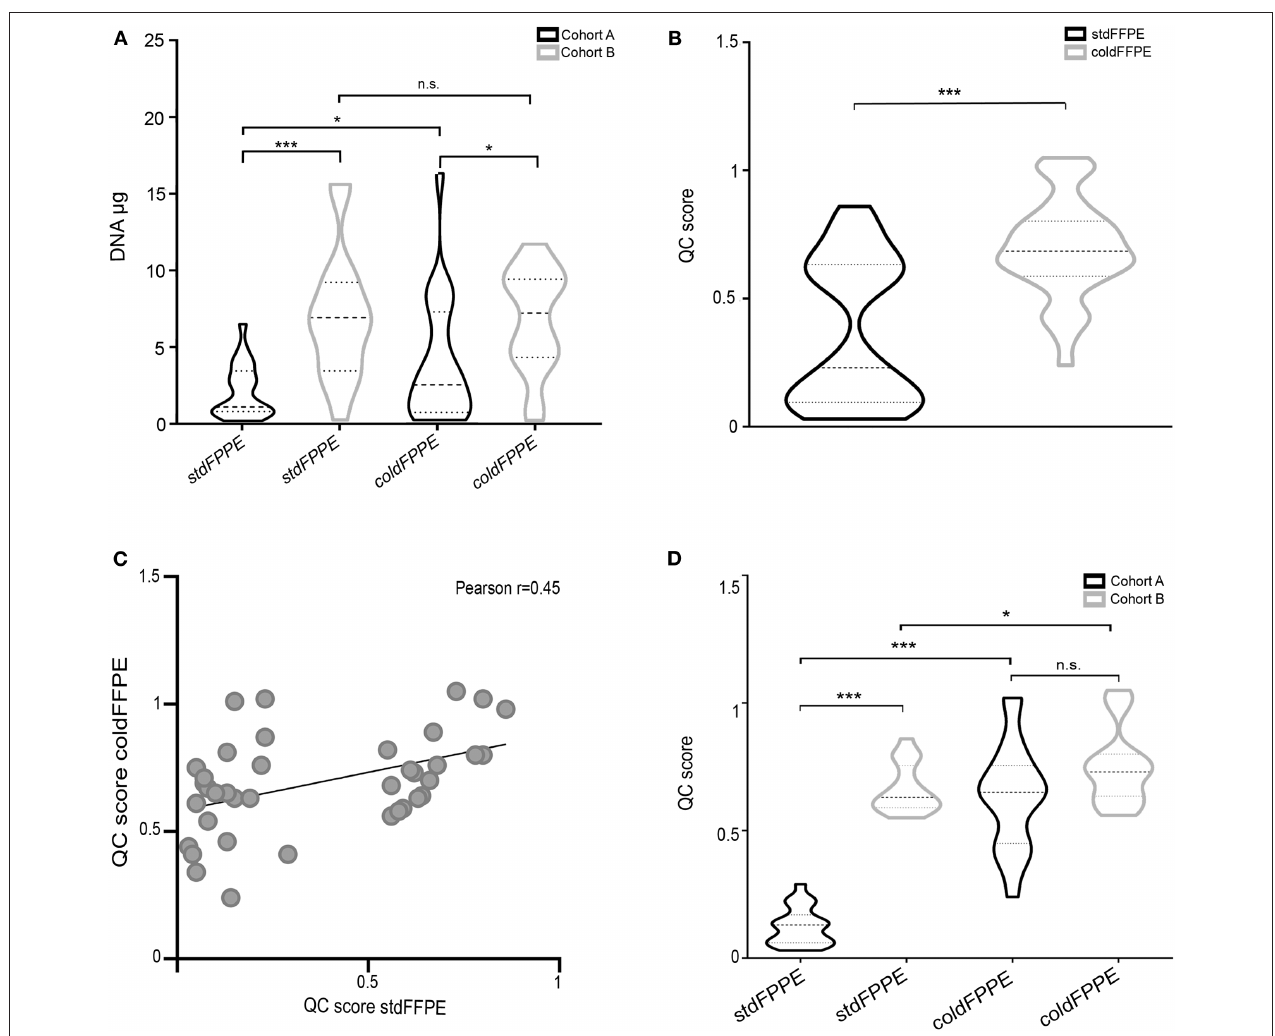
FIGURE 2 | Quantity and quality of DNA extracted from parallel samples. (A) DNA quantification of samples. Violin plots representing the DNA µ g purified from the specimens, grouped according to the fixation methods ( stdFFPE and coldFFPE ) and the time of cohort collection [Cohort A (collected 6 years prior to the study with DNA extraction at present time); Cohort B (collected at time of the present study with contextual DNA extraction)]. Cohort A was characterized by higher DNA yields for coldFFPE compared to stdFFPE samples (4.1 µ g vs. 2.1 µ g, p = 0.04). As for Cohort B, violin plots showed a median-around density distribution for both stdFFPE and coldFFPE samples that was significantly higher compared the same fixation protocol of Cohort A ( p = 0.03 for cold fixation and p = 0.0001 for standard fixation). (B) Violin plots representing the QC score distribution in the groups clustered according to fixation method. The stdFFPE cohort was characterized by heterogeneous QC scores with several samples in the low range (wider diameters of the black violin) and the DNA fragmentation was statistically significantly higher than in coldFFPE (gray violin). (C) Dot plot illustrating the Pearson correlation between the QC scores of corresponding samples fixed with the two protocols. The absence of a